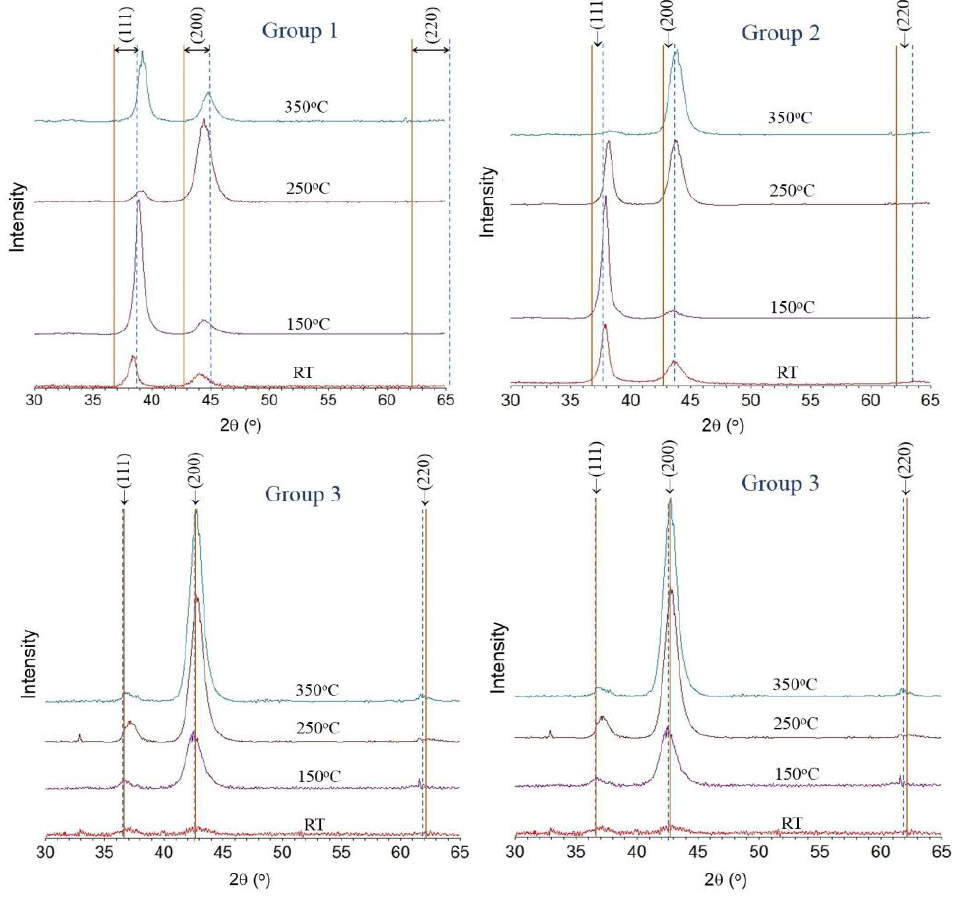
Figure 2. XRD diffraction patterns of the films from groups 1 – 4. The solid vertical lines show the (111), (200) and (220) fcc-based reflections for the TiN structure, while the dashed lines show corresponding positions for the SSN structure with lattice constants based on the measured N levels and Equation (1).